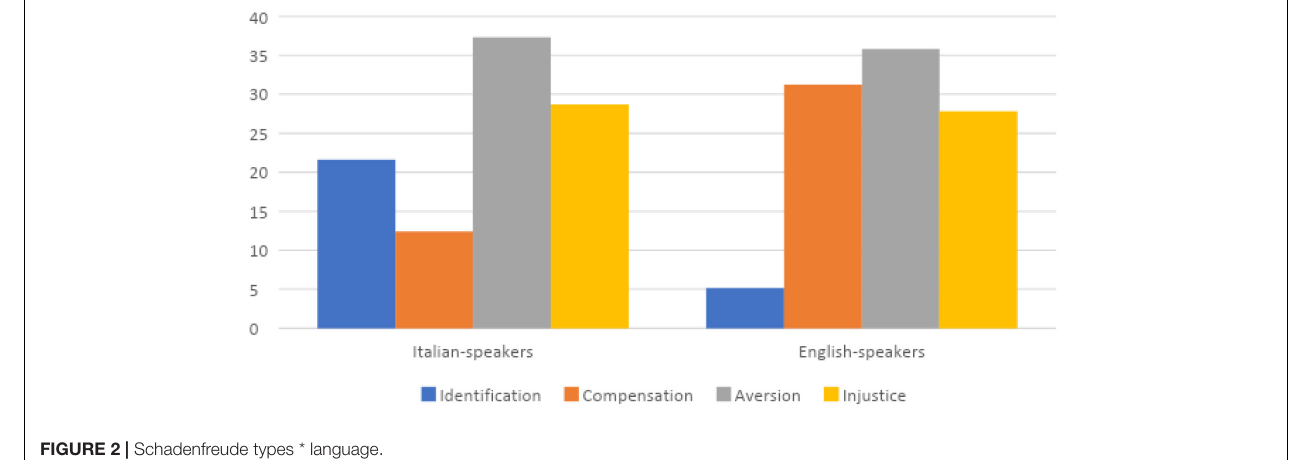
FIGURE 2 | Schadenfreude types * language.